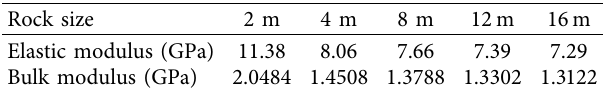
Table 11: Elastic modulus and bulk modulus with different rock sizes.